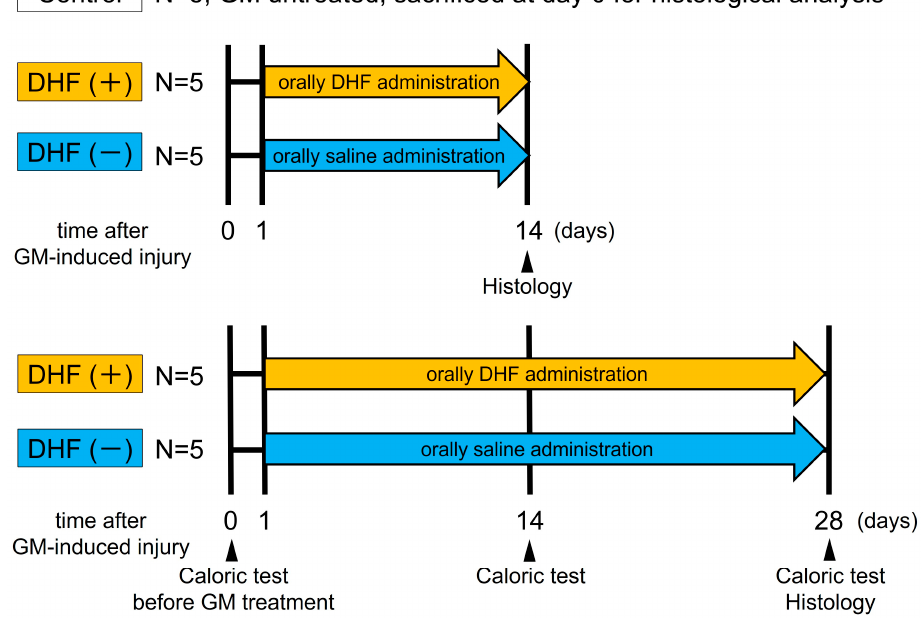
Figure 1. A schematic representation of the experimental procedure. Five animals served as GM–untreated histological controls. The GM–treated animals were divided into four groups. DHF (+) group received daily oral administration of DHF from day 1–14 or day 1–28 ( n = 5, each) after GM–induced injury. DHF ( − ) group received oral saline after GM-induced injury ( n = 5, each). DHF, 7, 8–Dihydroxyflavone; GM, gentamicin.